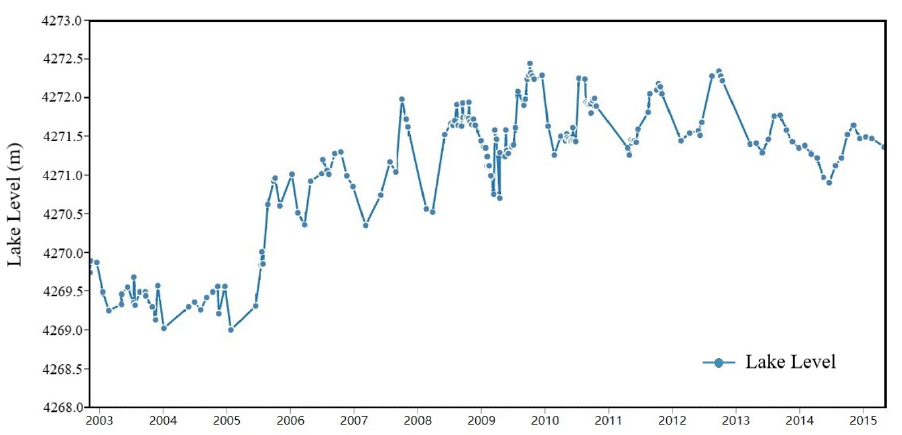
Figure 14. Monthly average water level of Ngoring Lake during the period 2003–2015.